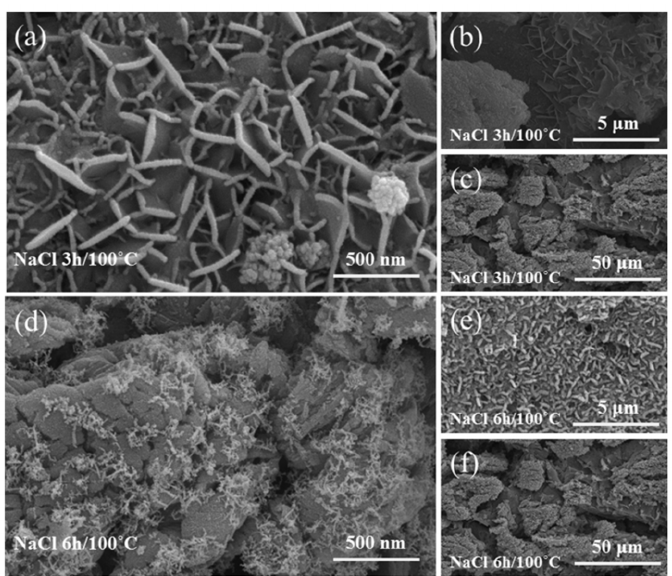
Figure 11. FE-SEM images of stainless-steel surface after dipping in NaCl solution. ( a – c ) dipped 3 h at different magnifications. ( d – f ) dipped 6 h at different magnifications. Reprinted with permission from Ref [62]. Copyright 2018 Elsevier.